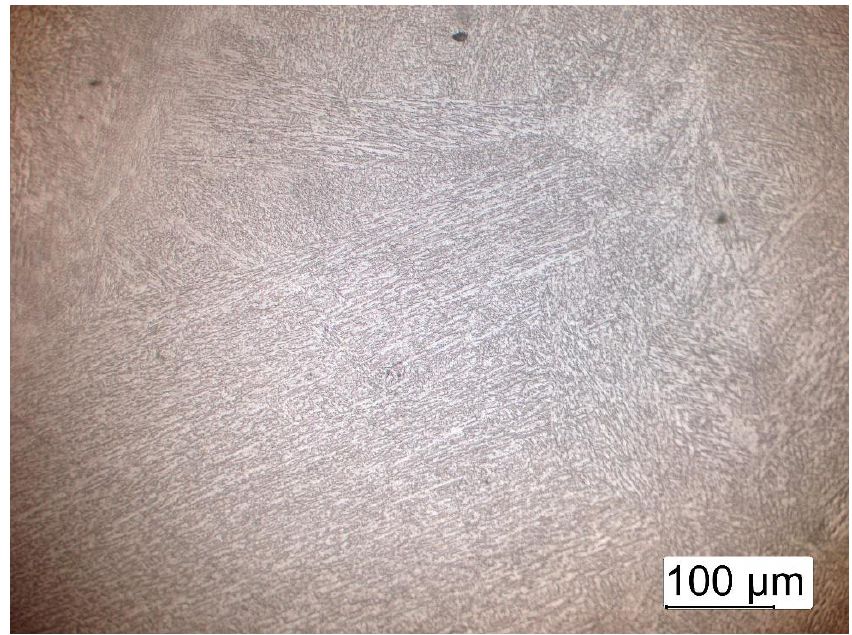
Figure 7. Micrography of the pinion shaft head after forging in the same area of the grain flow shown in Figure 6.